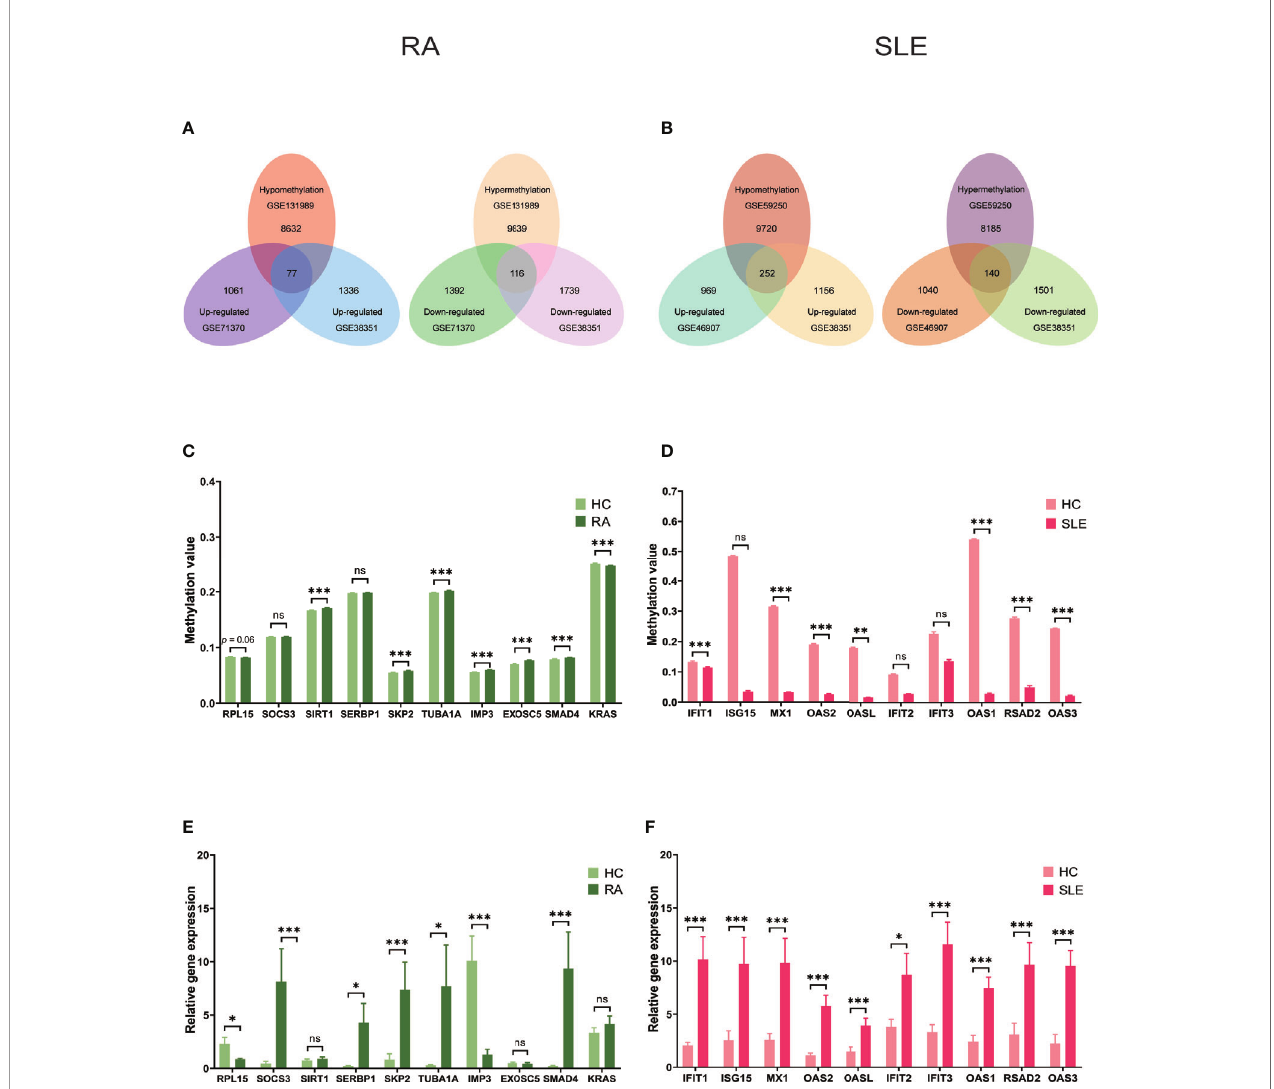
FIGURE 8 | Identi fi cation of aberrantly methylated DEGs of CD14 + monocytes in RA and SLE. (A) Aberrantly methylated DEGs of CD14 + monocytes in RA and (B) SLE; (C) Methylation level of top 10 hub genes in CD14 + monocytes from RA and (D) SLE; (E) Expression levels of top 10 hub genes in CD14 + Monocytes from RA and (F) SLE. ns, not signi fi cant. *p < 0.05; **p < 0.01; ***p <